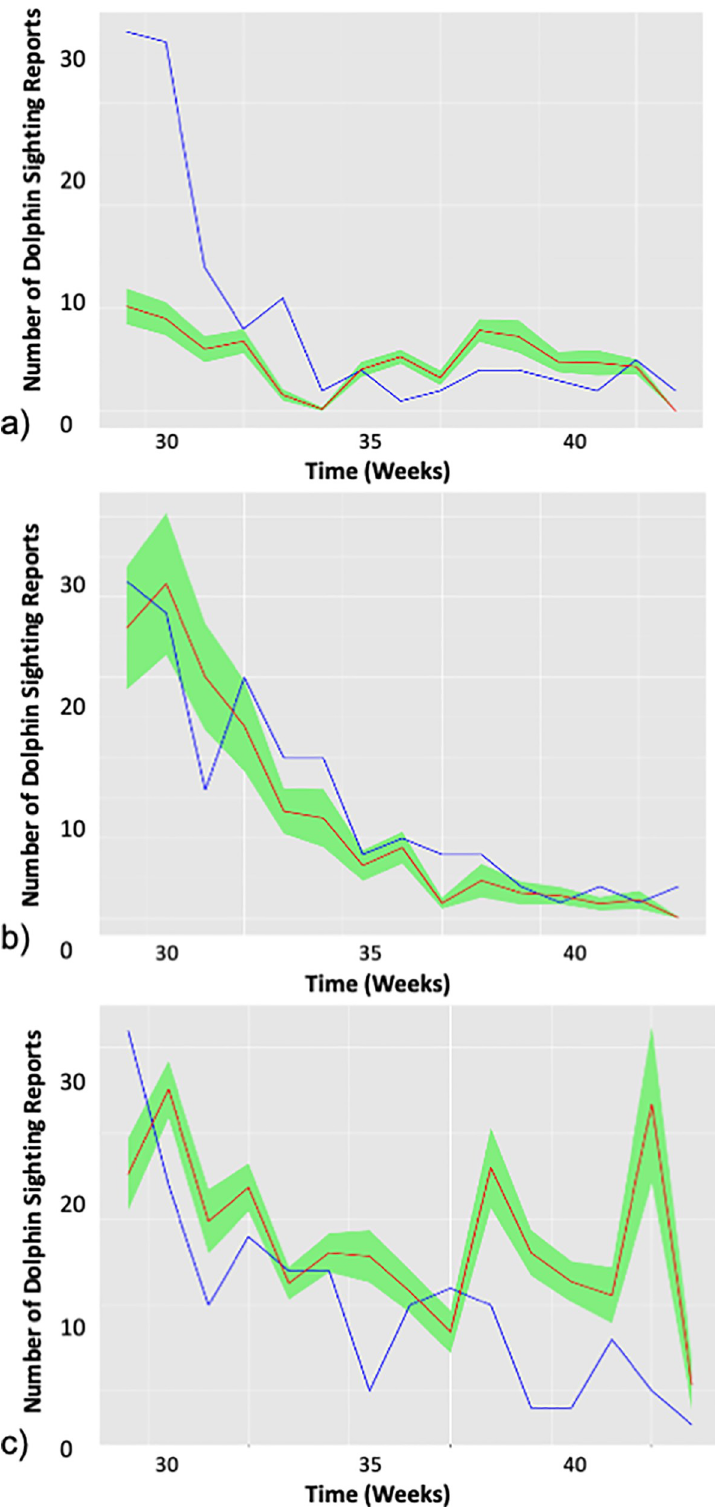
Fig 7. Predicted versus actual bottlenose dolphin sightings. Number of bottlenose dolphin sightings predicted using the final generalized additive models (red line) and the confirmed Chesapeake DolphinWatch sightings during between June and October 2019 (blue line) in the Upper (a), Middle (b), and Lower (c) Bay segments. Standard error